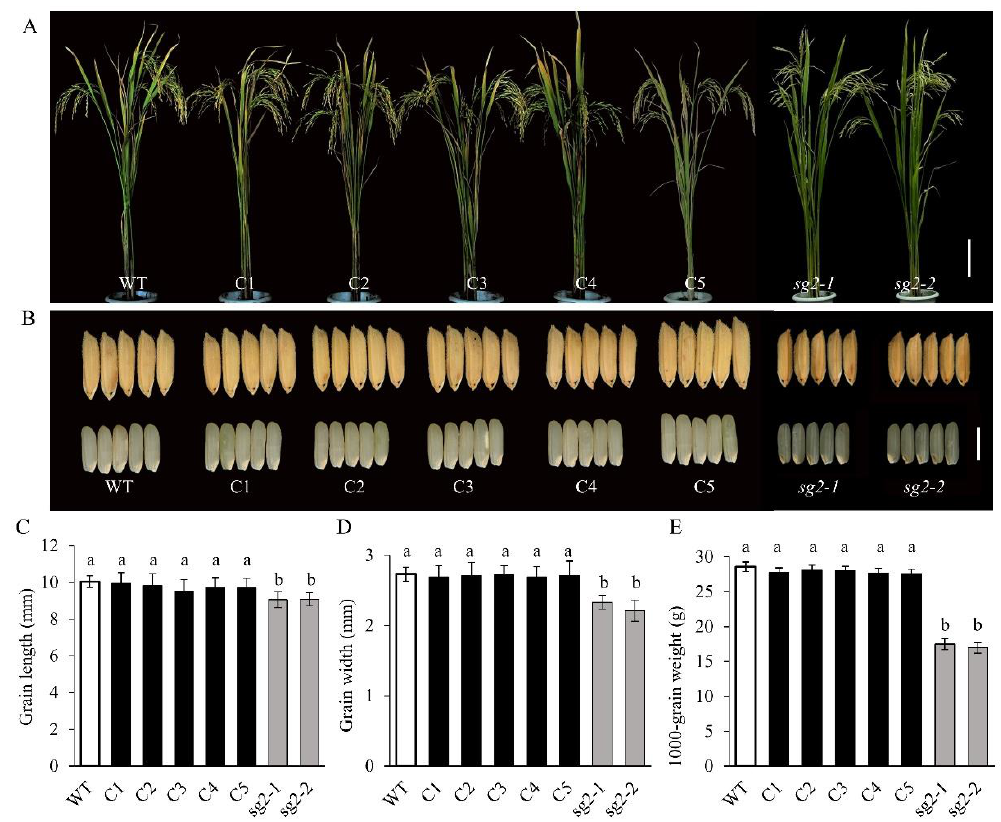
Figure 4. Phenotypic characterizations of complementation lines. ( A ) Plant comparison of wild-type (WT), complementation lines at the maturity stage. C1–C5 represent the five complementation transgenic lines. Bar = 20 cm. ( B ) Morphology of grain shape in WT, complementation lines. Bar = 2 mm. ( C – E ) Statistical data of the grain length ( C ), grain width ( D ), 1000-grain weight ( E ) in WT and complementation lines. Data are given as means ± SD. Di ff erent letters indicate statistically significant di ff erences at the p = 0.01 level by Student’s